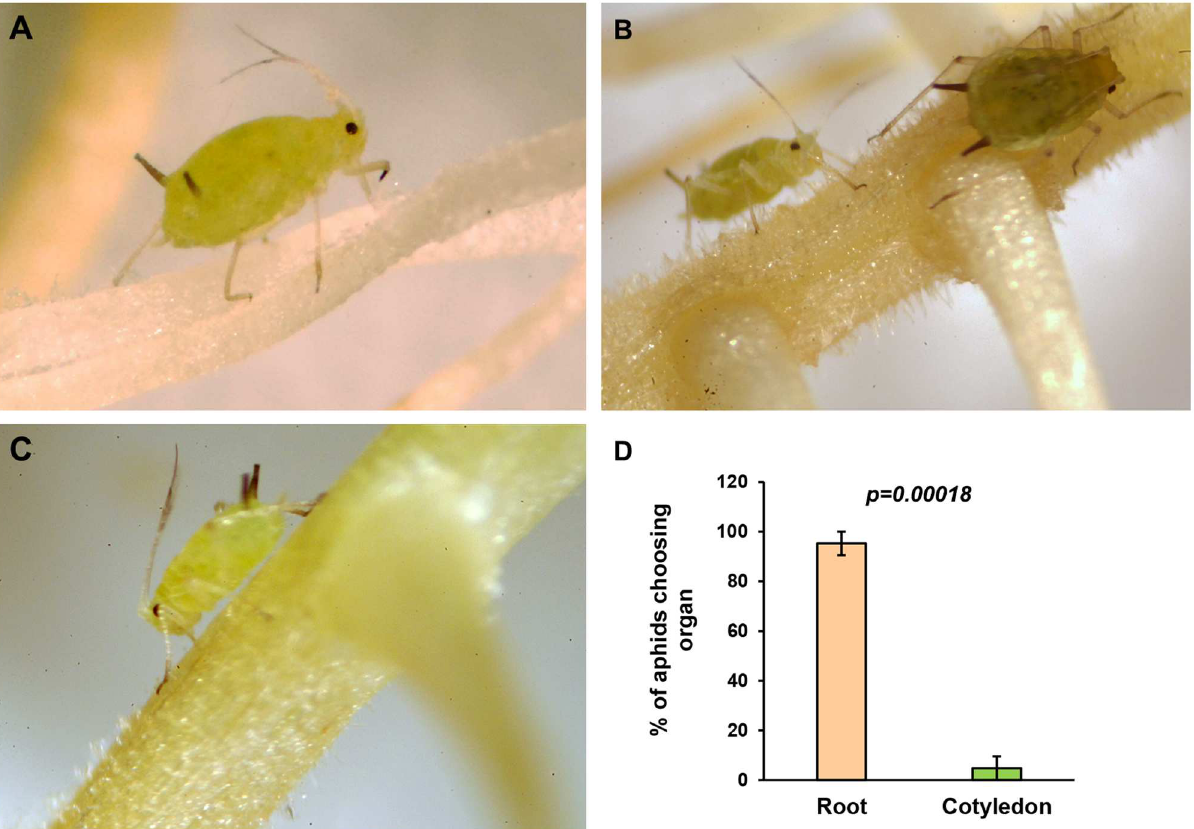
Fig 1. Soybean aphids feed on soybean hairy roots. Aphids were introducedto plates with individual hairy root systems producedby Agrobacterium rhizogenes infectionof soybeancotyledons.Roots were kept attached to the cotyledonand the wholesystem was kept on paper filter wetted with water. Aphids fed on young ( A ) or older ( B, C ) roots. D . Quantification of aphid feedingpreference. After five days of colonization, the number of aphids feedingon roots or cotyledons was recorded, and the percentage of aphidson each organ is reported. Error bars = standard error. Three independent experiments with three replicates each were analyzedusing Student’s t -test.